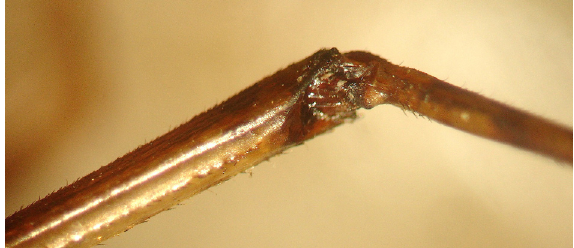
Image 1. Entire specimen (female).